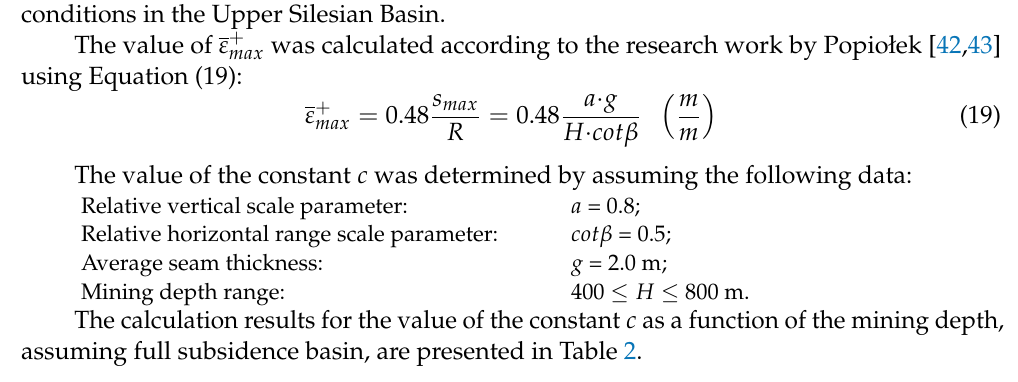
Table 2. Calculation results for the value of the constant c (own study). Exploitation Depth